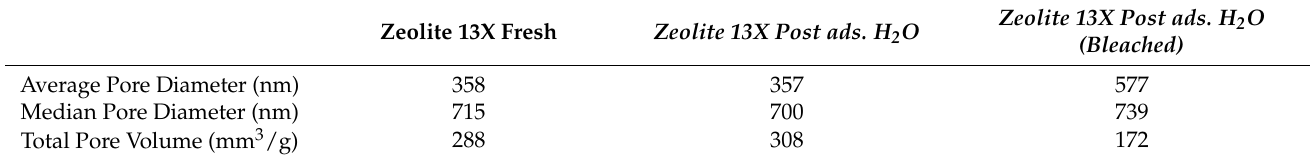
Table 4. Results of the porosimetry with Hg intrusion.